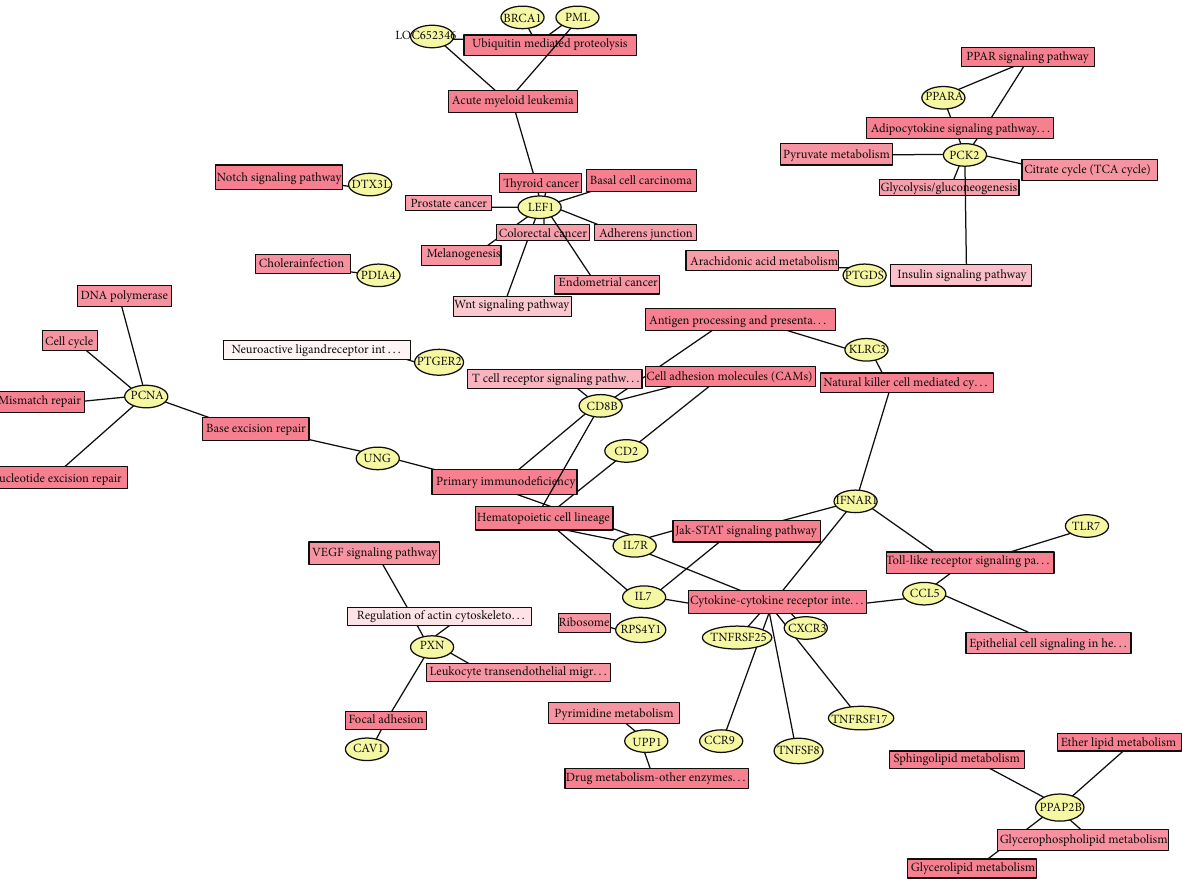
Figure 4: Enriched signaling pathways with significant association with estrogen-relevant DEGs. 116 estrogen-relevant DEGs were subjected to performing of the signaling pathway analysis based on KEGG databases. A group of 30 DEGs are found to be connected functionally, including LEF1, TNFRSF25, PDIA4, PXN, PTGDS, TNFRSF17, KLRC3, TNFSF8, PTGER2, CCR9, PCNA, UPP1, CD8B, CAV1, UNG, PPAP2B, CD2, LOC652346, IFNAR1, BRCA1, IL7R, PML, IL7, PPARA, CCL5, PCK2, CXCR3, DTX3L, RPS4Y1, and TLR7. Blue stars indicate that these 9 DEGs are highly related to the